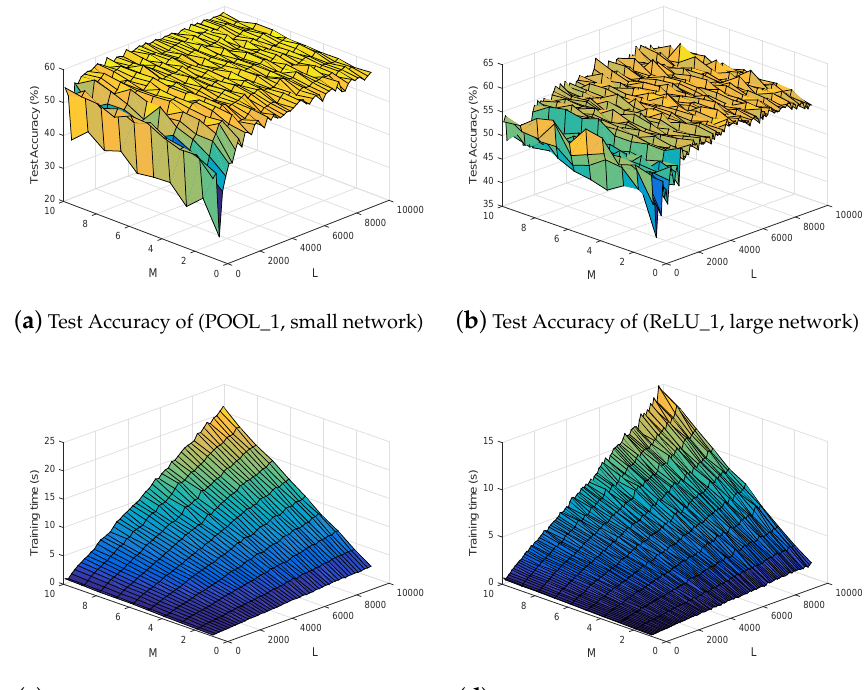
Figure 6. Analysis of the ELM based ensemble with respect to # individual models M and # hidden nodes L on VAIS dataset. Test Accuracy in the case of: ( a ) POOL_1 features using the small network; and ( b ) ReLU_1 features using the large network. The training time in the case of: ( c ) POOL_1 features using the small network; and ( d ) ReLU_1 features using the large